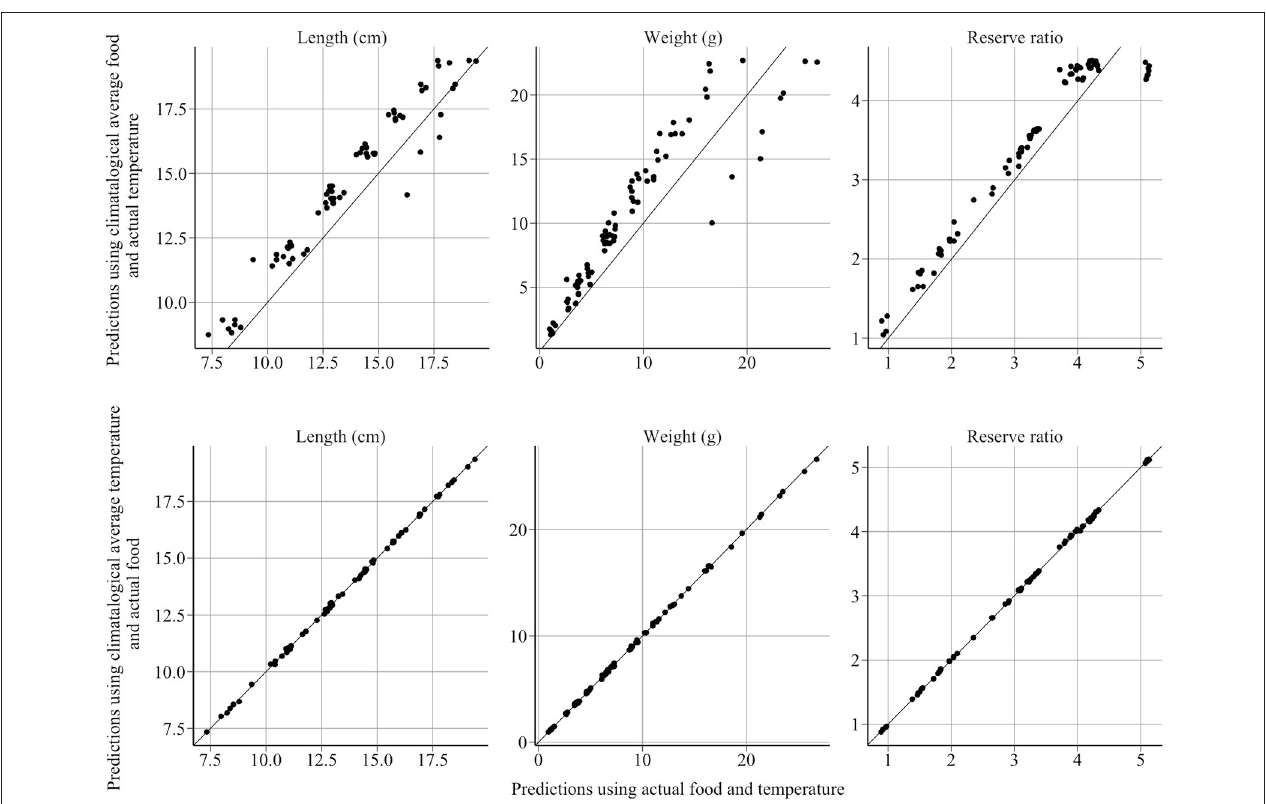
FIGURE 5 | Model sensitivity of length, weight and reserve ratio to food and temperature. The x-axis represents the model predictions and the y-axis represents predictions using climatological averages. Year-to-year changes in sandeel size and energy are driven by variation in food, not